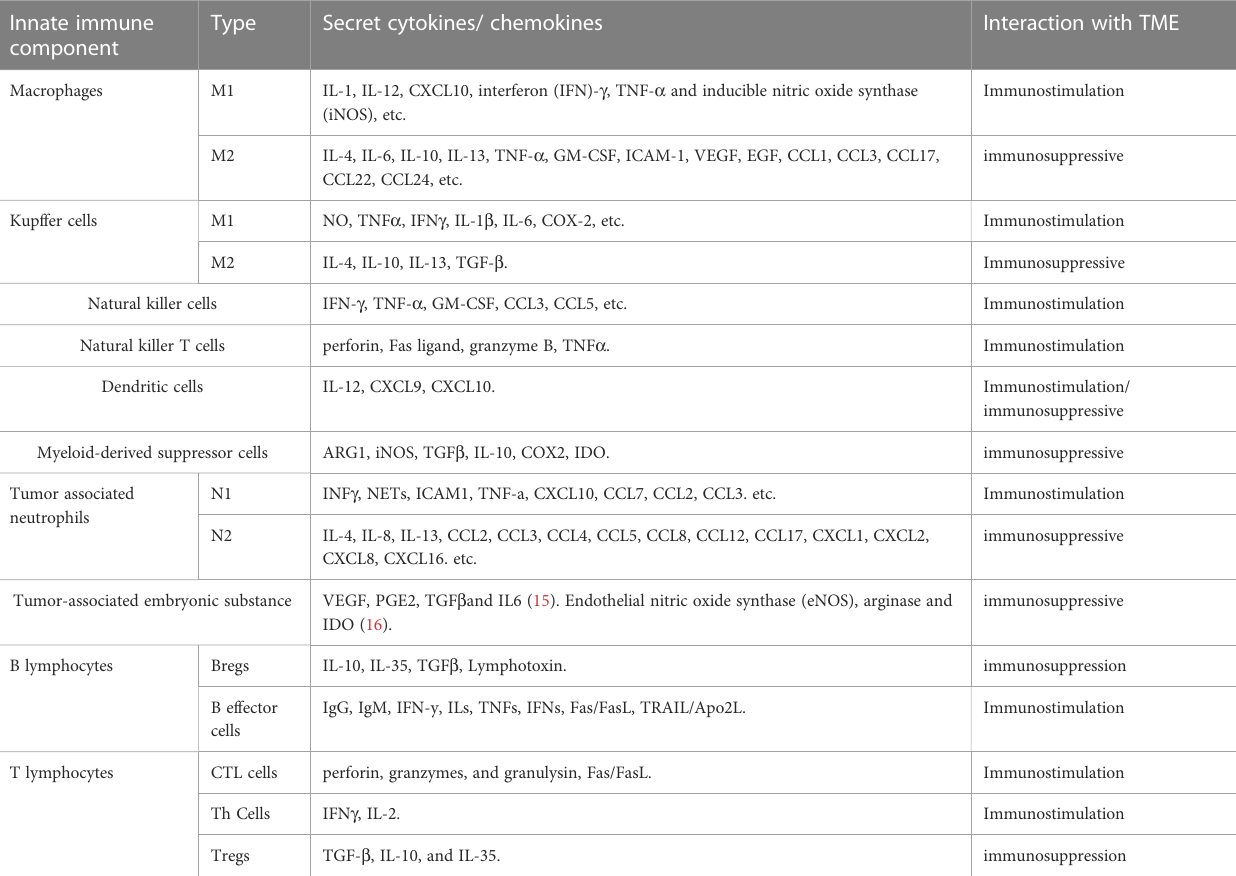
TABLE 1 Role of main immune components in microenvironment and potential